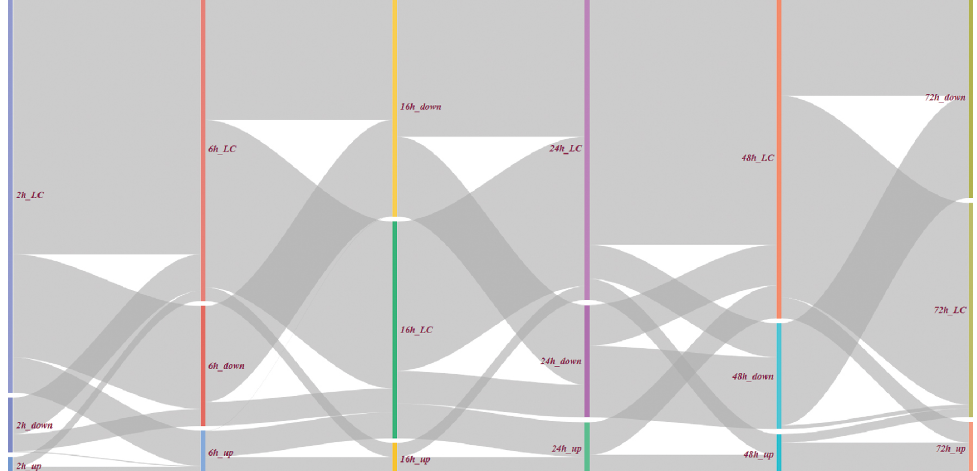
Figure 4: Groups of differentially expressed genes between pairs of consecutive timepoints. The number of genes is the same for each timepoint. Genes, which are differentially expressed in only one time point are prefixed with “ _LC ” in all others (LC; low-change). This example is the response of U87-MG cell lines to Camptothecin which shows, that the effect is highest after 16 h and 72 h (the smallest amount of LC), the biggest change in the series is also from/to 16 h and 72 h and there are virtually no genes changing between up- and down-regulated (only the little line from “ 2 h_up ” and “ 6 h_down ”